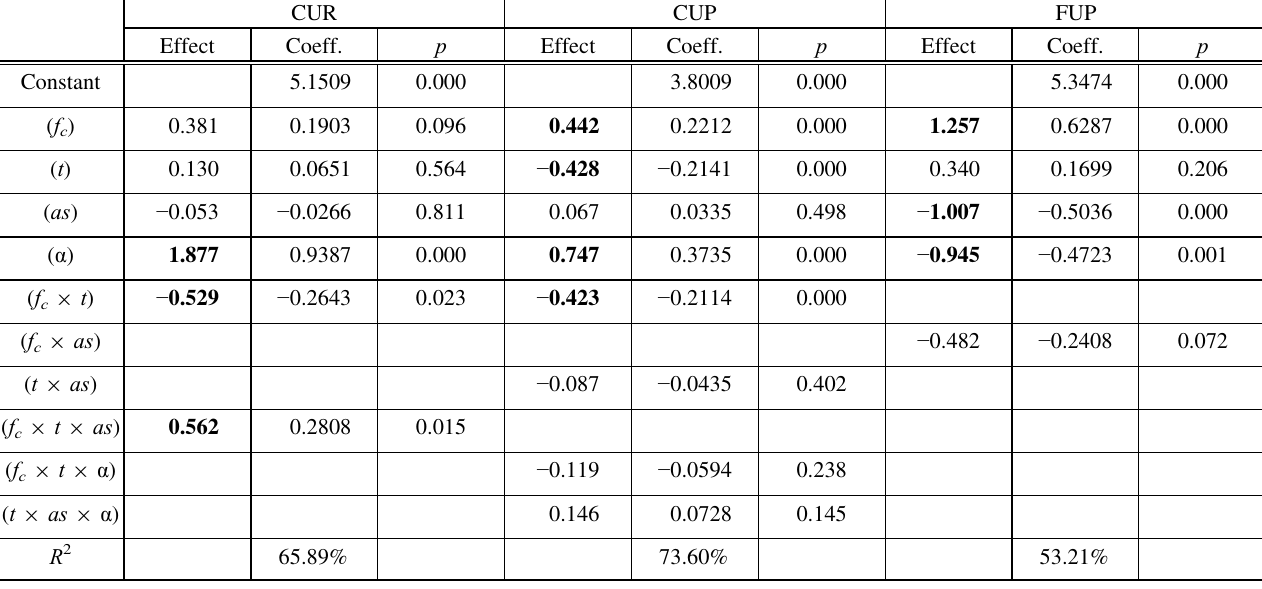
Table 11 A reduced model for each loading geometry in the group two of experiments a